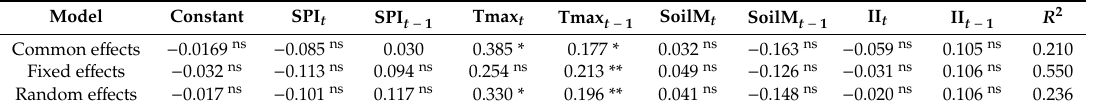
Table 4. Results of panel data models for relationships between the severity of forest fires with the intensity of climate hazards and insect infestation of the current year and the previous year in NE Iran.